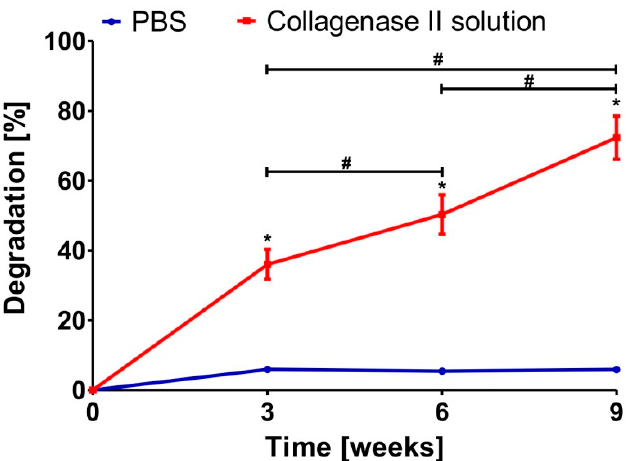
Figure 3. Degradation percentage of Cur_WPI biomaterial after 9-week incubation in PBS and 0.02% collagenase II solution. * Significantly different results compared with data obtained in PBS solution; # significantly different results between data obtained in 0.02% collagenase solution after different time of incubation; one-way ANOVA test followed by Tukey’s multiple comparison, p < 0.05.